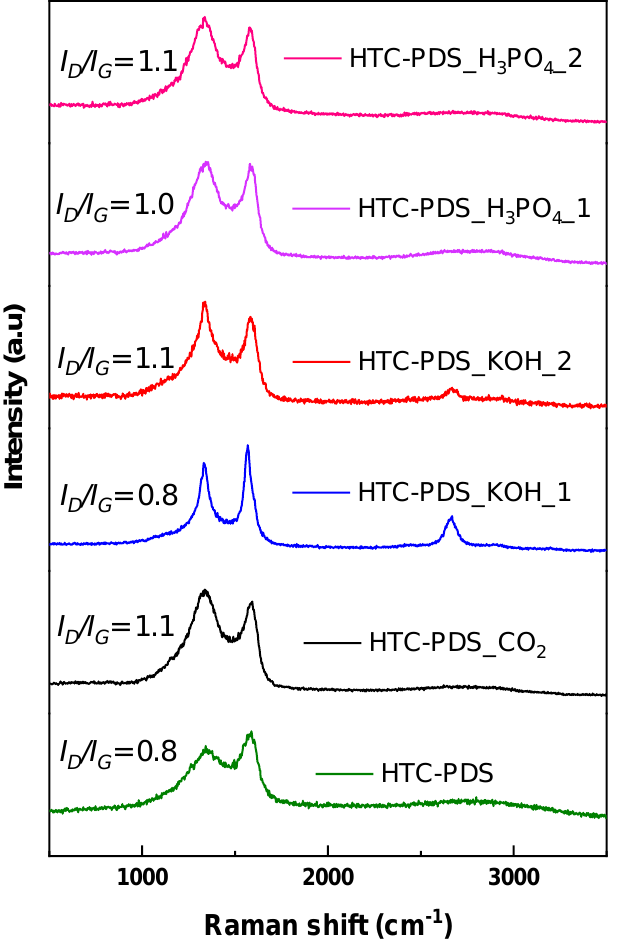
Figure 2. Raman spectra for the HTC-PDS and the respective activated carbon materials.